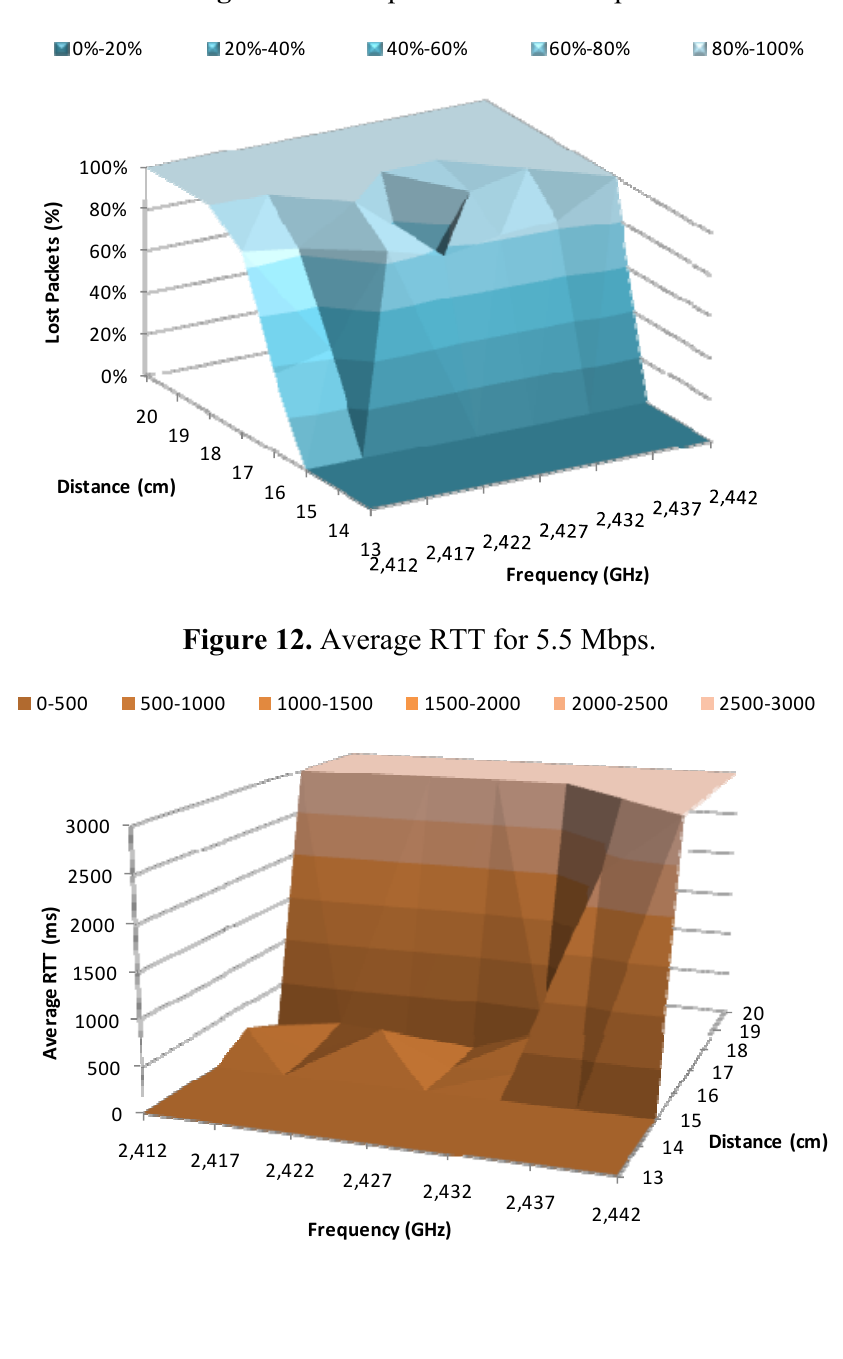
Figure 11. Lost packets for 5.5 Mbps.